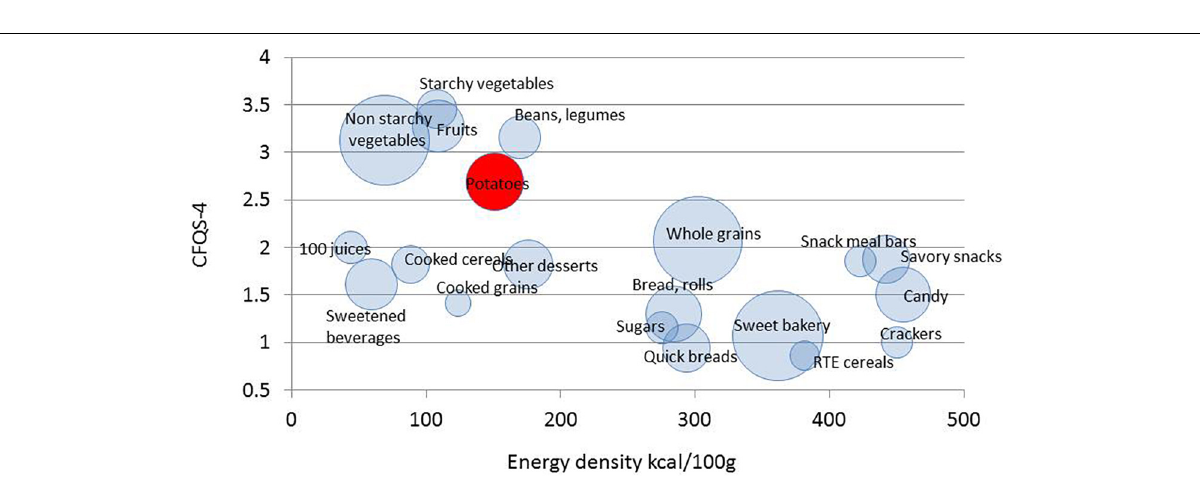
Frontiers in Nutrition |